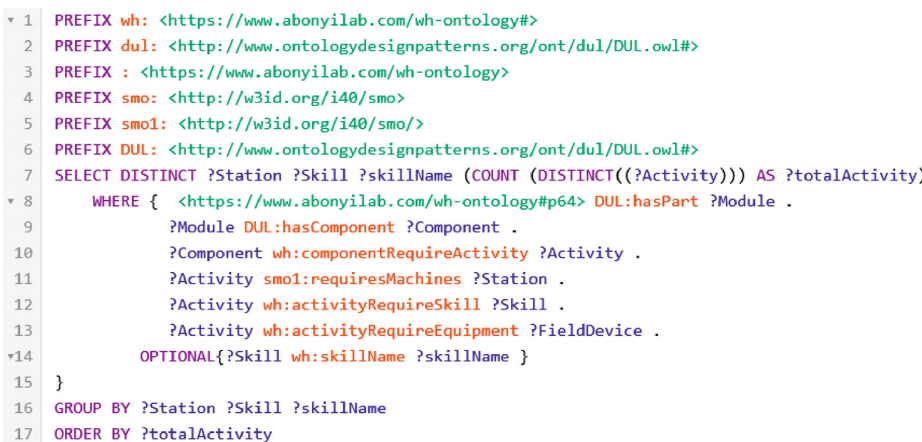
Figure 22: SPARQL